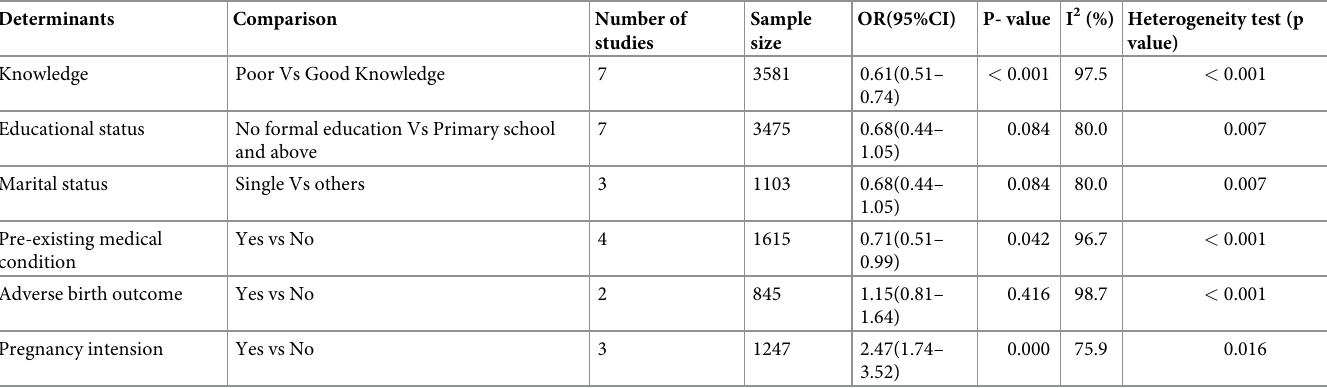
Table 3. Factors associated with utilization of preconception care among women in